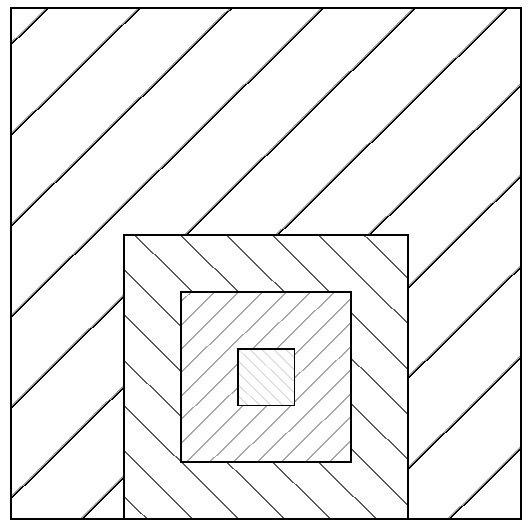
Fig. 6. Illustration of the spatial structure for academic test run. Hatchings correspond to different grid sizes. Table 3. Synopsis of spatial structure for academic test case.